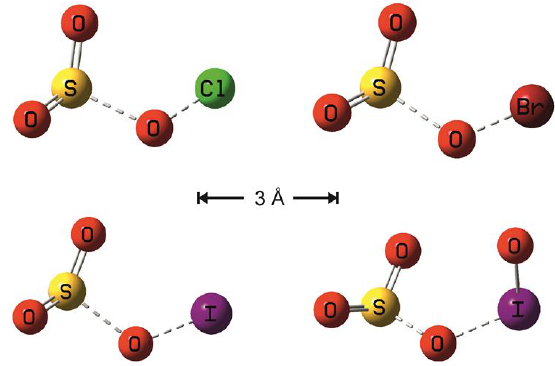
Figure 7. Transition state geometries for ClO, BrO, IO, and OIO + SO 2